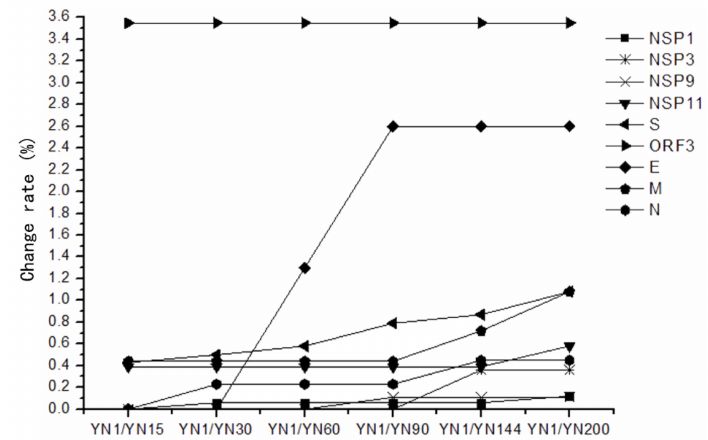
Figure 5. The change rate of non-structural and structural proteins of different passages compared with their virulent parental strain YN1. The change rate is the percentage of changed amino acid in their corresponding proteins (%). Non-structural proteins: NSP1, NSP3, NSP9, and NSP11 proteins; Structural proteins: S, ORF3, E, M, and N proteins.